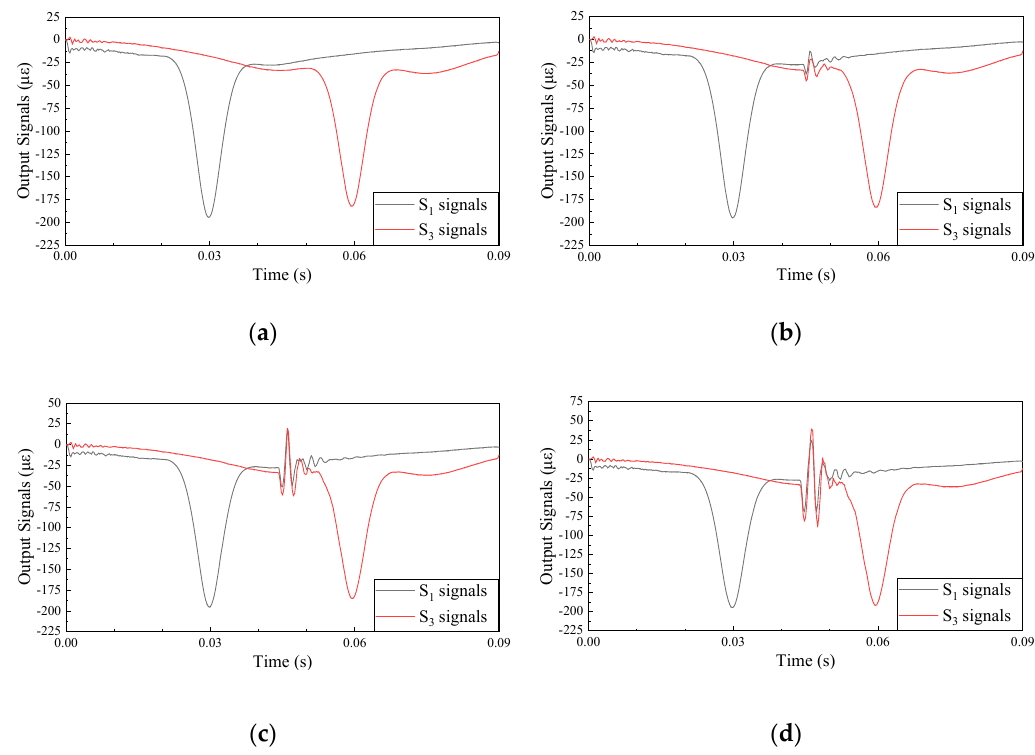
Figure 12. Output signals of Plan I under its most unfavorable condition: ( a ) Without wheel flat; ( b ) wheel flat depth of 0.1 mm; ( c ) wheel flat depth of 0.3 mm; and ( d ) wheel flat depth of 0.5 mm.